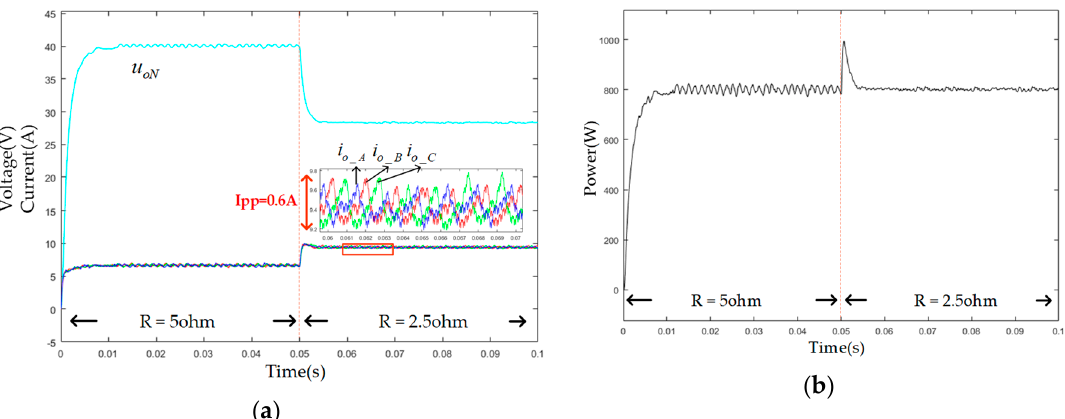
( a ) ( b ) Figure 16. PR simulation result under DC grid mode. ( a ) voltage and current; ( b ) output power. Figure 16 shows the detailed port voltage, current, and power in DC grid mode. During this period, a current step happens at 0.05 s to test the speed of changing power from − 1 kW to 1 kW. The power in Figure 16b shows the control speed and accuracy of this control strategy. The current ripple is 0.6 A peak-to-peak. ( a ) ( b ) Figure 17. PR simulation result of switch state port voltage and current. ( a ) from DC Load Mode to AC Load Mode; ( b ) from AC Load Mode to DC Load Mode. Figure 17 shows the detailed port voltage and current during the switch state. Since in the simulation, the switch can be cut off and put in almost immediately, it shows a short and smooth transient state of switching between AC and DC mode.